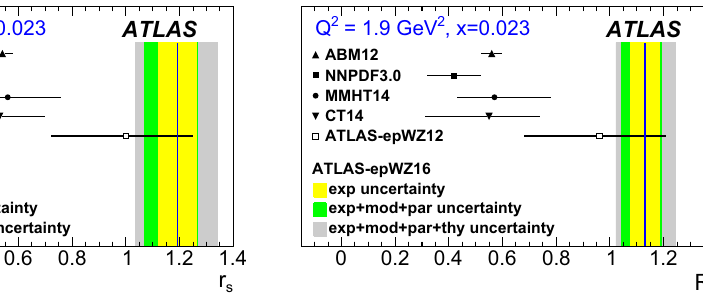
Fig. 31 Determination of the relative strange-to-down sea quark frac- tions r s ( left ) and R s ( right ). Bands show the present result and its uncertainty contributions from experimental data, QCD fit, and theo- retical uncertainties, see text; closed symbols with horizontal error bars